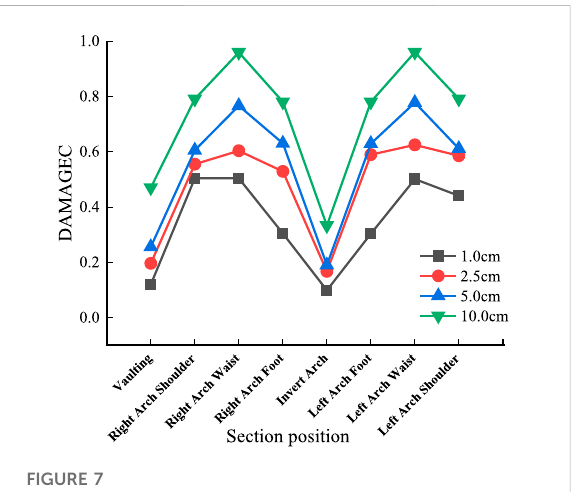
FIGURE 7 Damage parameters of various parts of positive fault